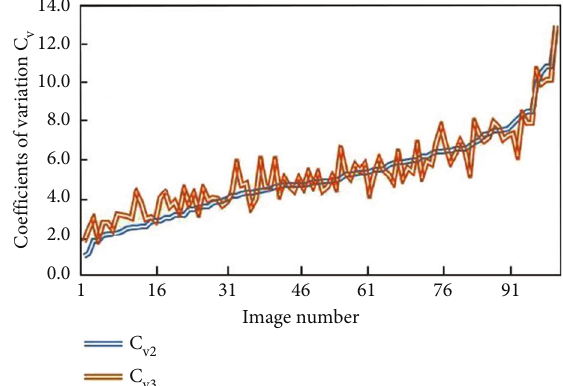
Figure 9: Distribution of coe ffi cients of variation C